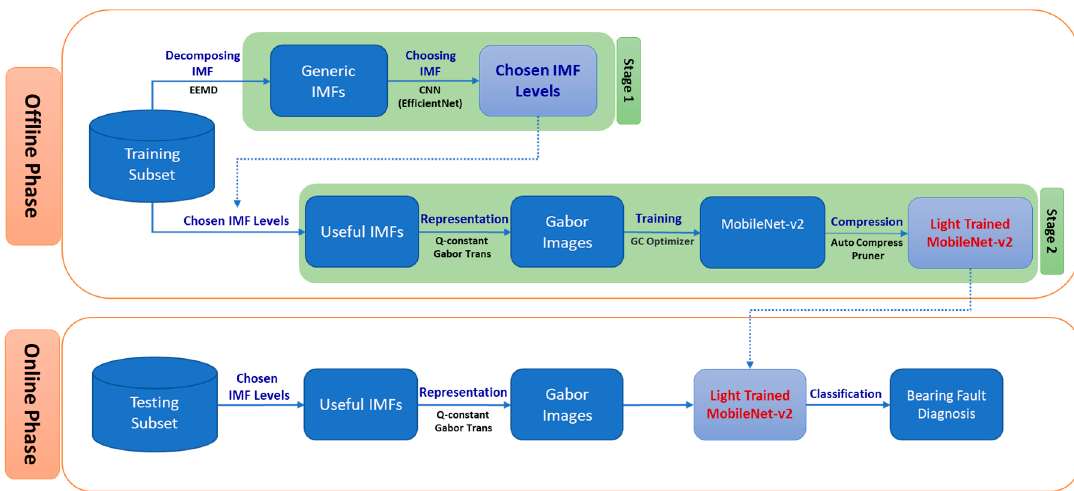
Figure 1. Proposed bearing fault diagnosis method for embedded systems.